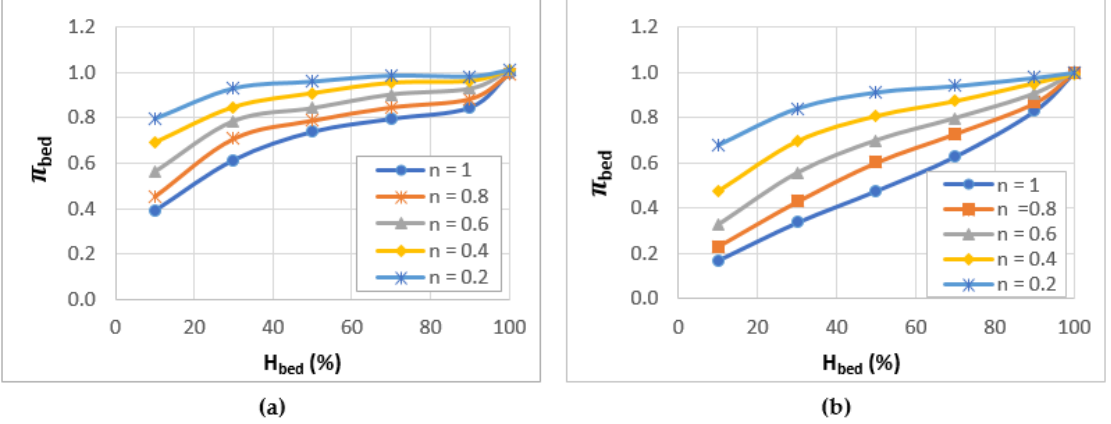
Figure 9. Dimensionless bed shear stress vs. bed height for conditions e = 0.9 and Q = 5 × 10 − 5 m 3 /s and different diameter ratios: ( a ) k = 0.25; and ( b ) k =